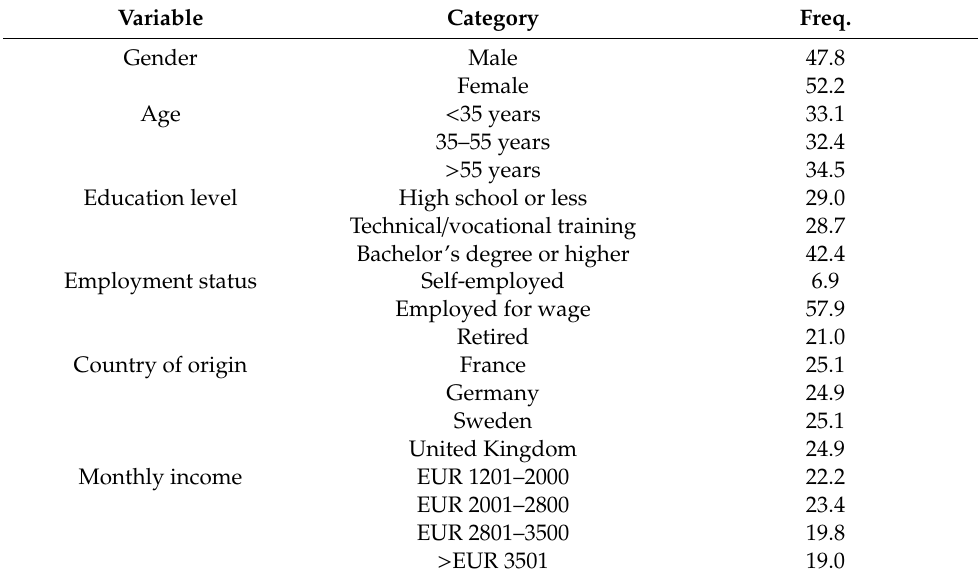
Table 2. Socio-demographic